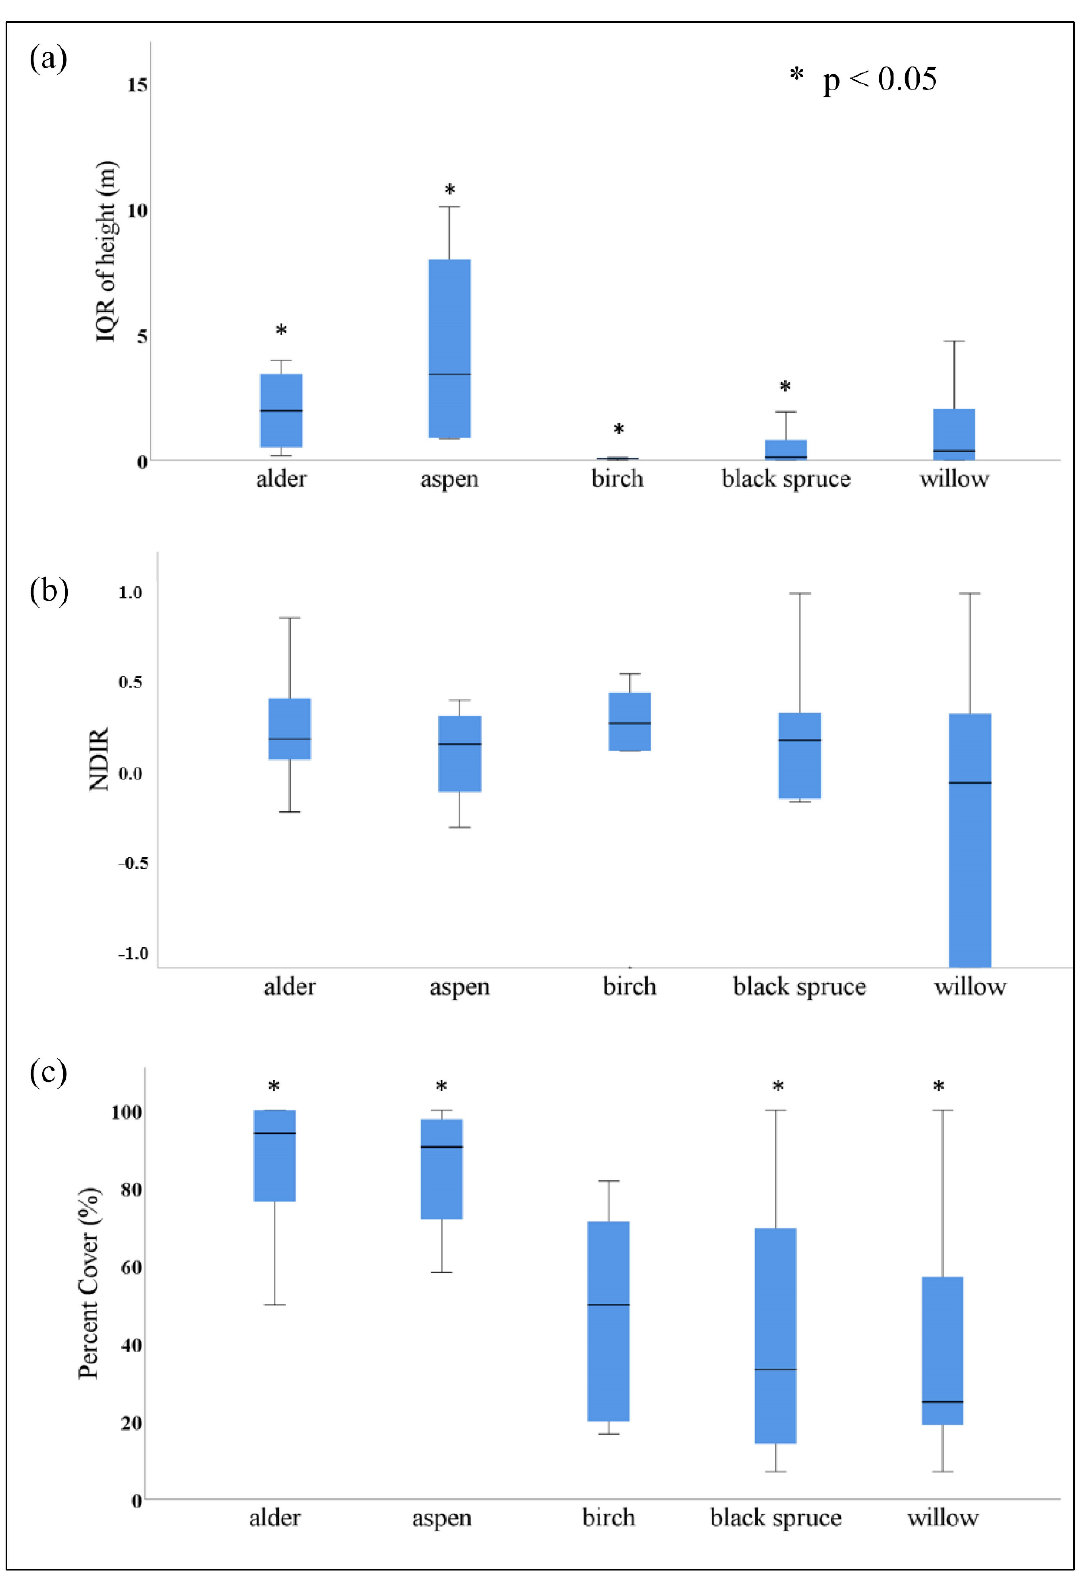
Figure 4. Box plot of ( a ) IQR of height, ( b ) NDIR, and ( c ) percent cover used to separate between species. The values are derived from lidar data for deciduous and conifer species identified in unmixed plots in the field ( n = 44).